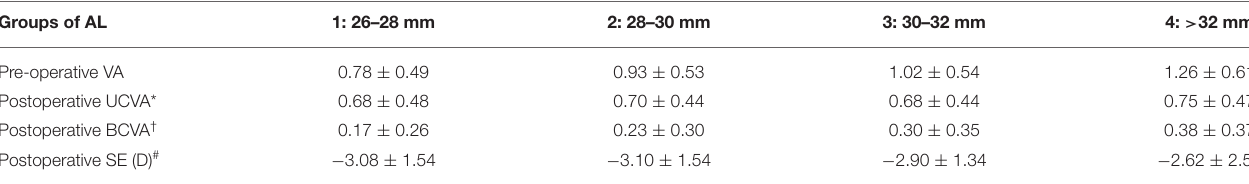
TABLE 4 | Visual and refraction outcomes of highly myopic cataract eyes in different subgroups of axial length. Groups of AL 1: 26–28 mm 2: 28–30 mm 3: 30–32 mm 4: > 32